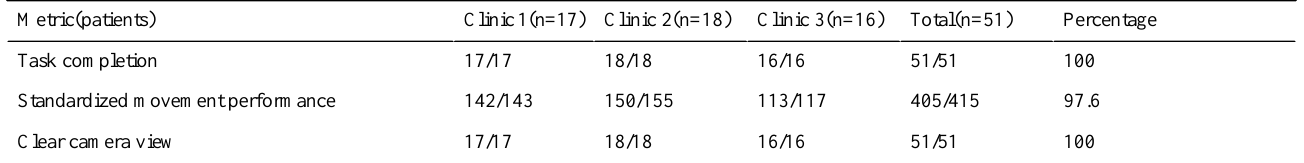
Table 4. Metrics of usability (effectiveness) for each clinic and the